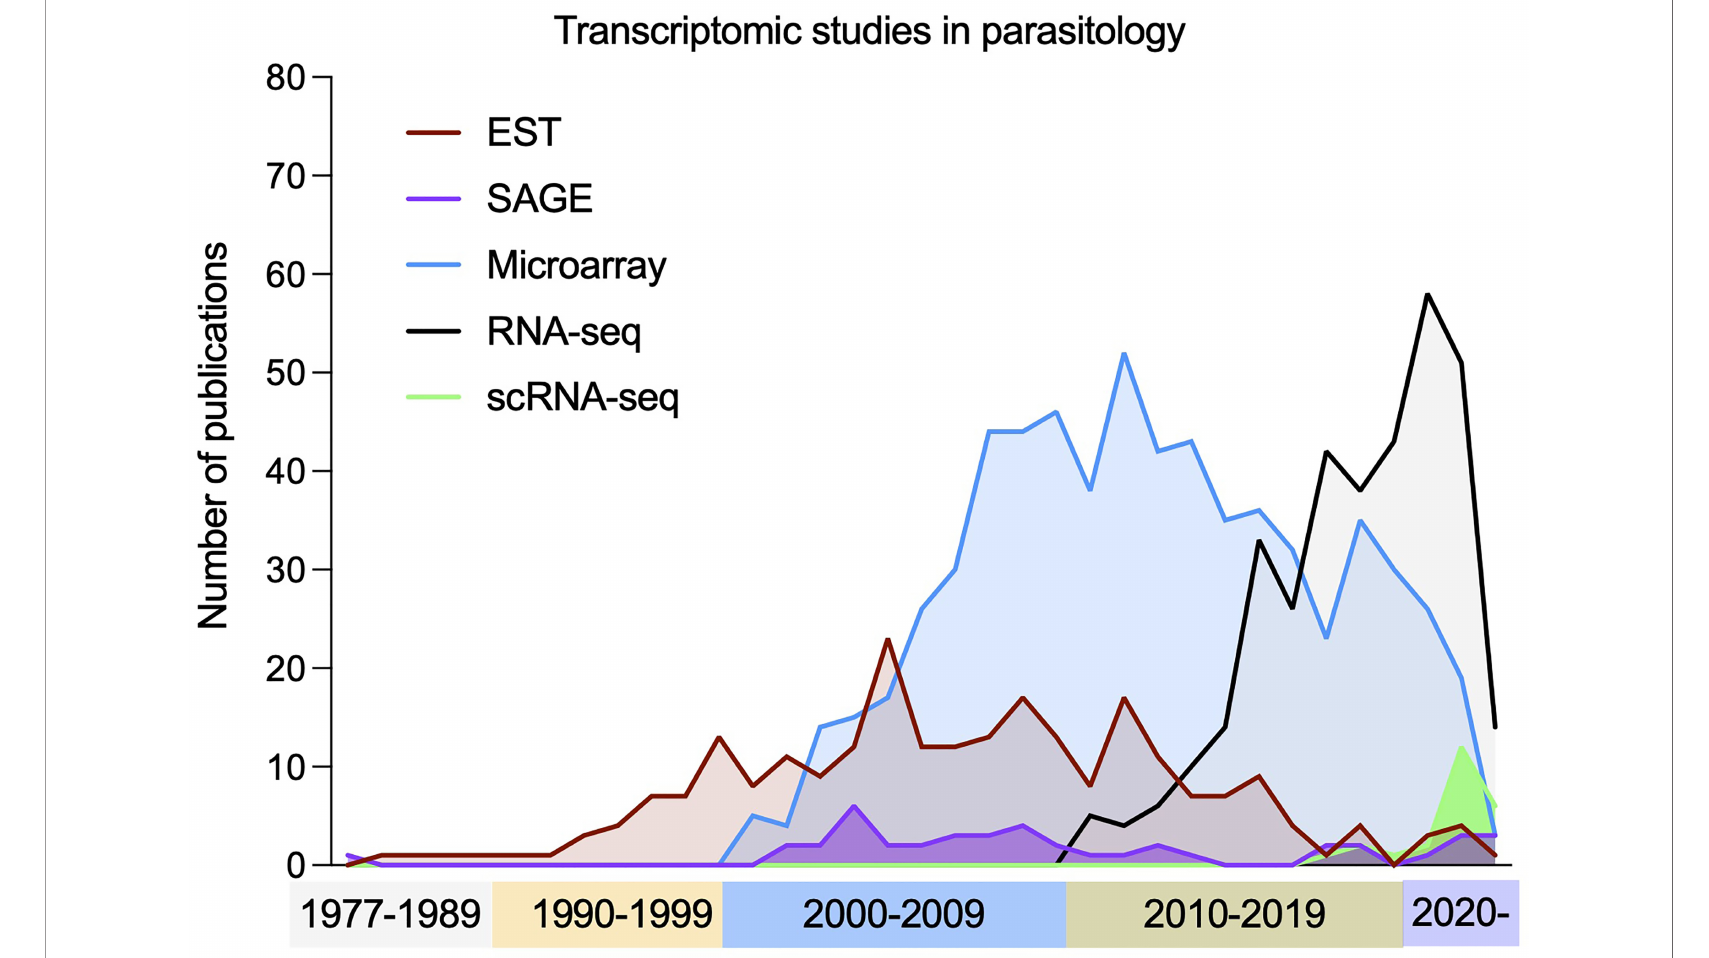
FIGURE 4 | Publication of transcriptomic studies in parasitology. The use of transcriptomics has had a rapid increased over time, with early techniques (ESTs, SAGE and microarrays) becoming less frequently used in favour of bulk RNA-seq. Most recently the number of studies using scRNA-seq methods has increased to deconvolve mixed populations. Note: *Each term was searched for in publication titles and/or abstracts, along with at least one species of unicellular parasites included in the VEuPathDB database (Amos et al.,